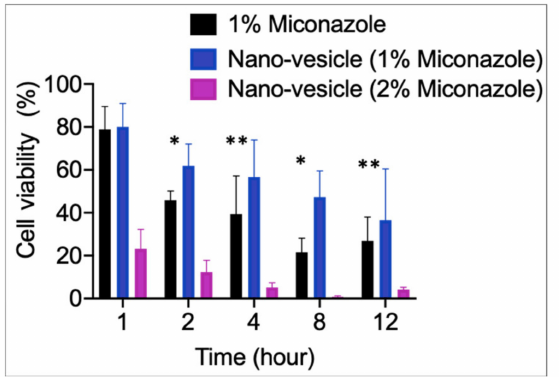
Figure 6. Cell viability at varying time points. The 2% miconazole nano-vesicles displayed lower cell viability at all time points when compared with 1% miconazole nano-vesicle and 1% free miconazole. All data are presented as mean ± SE ( n = 9). * p < 0.05 and ** p < 0.5 for nano-vesicle compared to (Actavis) of 1%